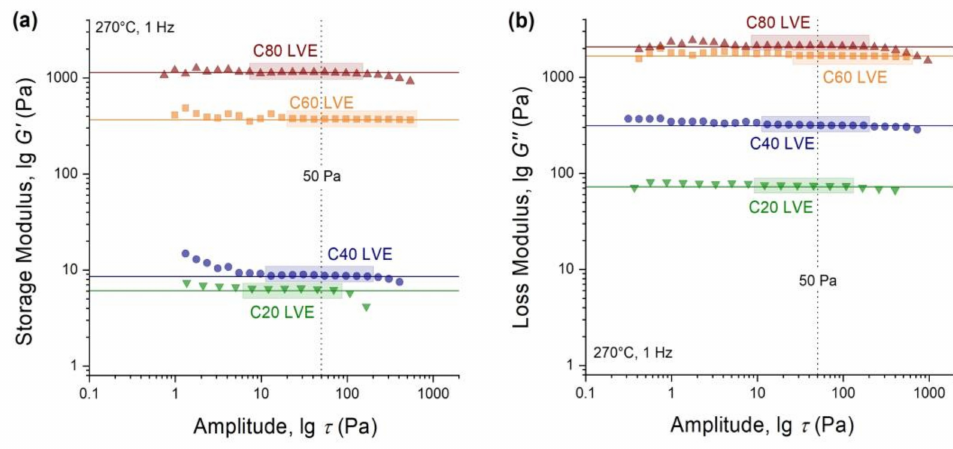
Figure 4. Dependence of the storage modulus ( a ) and loss modulus ( b ) on the stress amplitude for C20–C80 copolyester melts at 270 ◦ C.